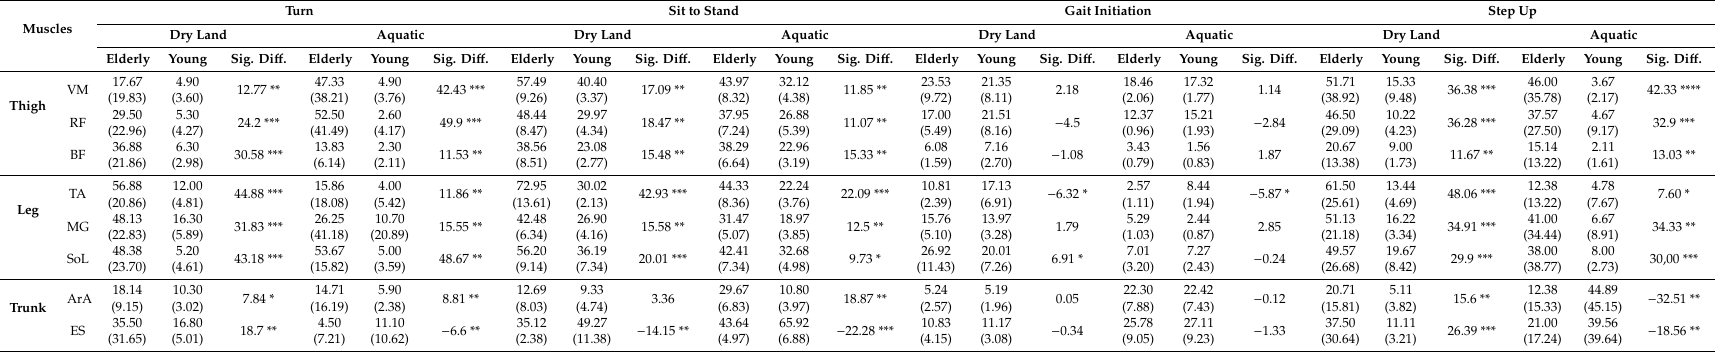
18.14 (9.15) Trunk ArA ArA: Anterior Rectus Abdominis; BF: Biceps Femoris; ES: Erector Spiane; GM: Gactocnemus medialis; RF: Rectus Femoris; SoL: Soleus; TA: Tibialis Anterior; VM: Vastus Medialis; *: p < 0.05; **: p < 0.005; ***: p < 0.001. Table A2. Comparison, within the same group (elderly or young), of normalized muscle activation, in both settings (dry-land or aquatic enviroment). Turn SittoStand GaitInitiation StepUp Muscles Elderly Young Elderly Young Elderly Young Elderly Young Dry ff . Dry ff . Dry ff . Dry ff . Dry ff . Dry ff . Dry ff . Dry ff . Land Aqua Sig. Di Land Aqua Sig. Di Land Aqua Sig. Di Land Aqua Sig. Di Land Aqua Sig. Di Land Aqua Sig. Di Land Aqua Sig. Di Land Aqua Sig. Di VM Thigh